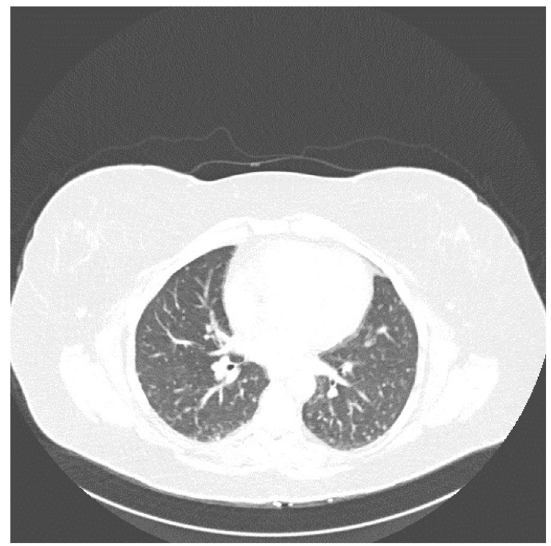
Fig. 1 Imaging findings. Selected axial non-contrast chest CT image shows bilateral multiple small nodules randomly distributed through both